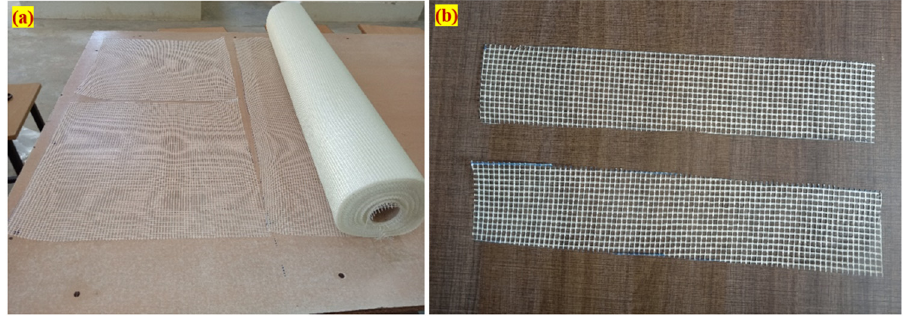
Figure 2. Details of glass fibre mesh. ( a ) Mesh roll and ( b ) rectangular pattern of mesh.